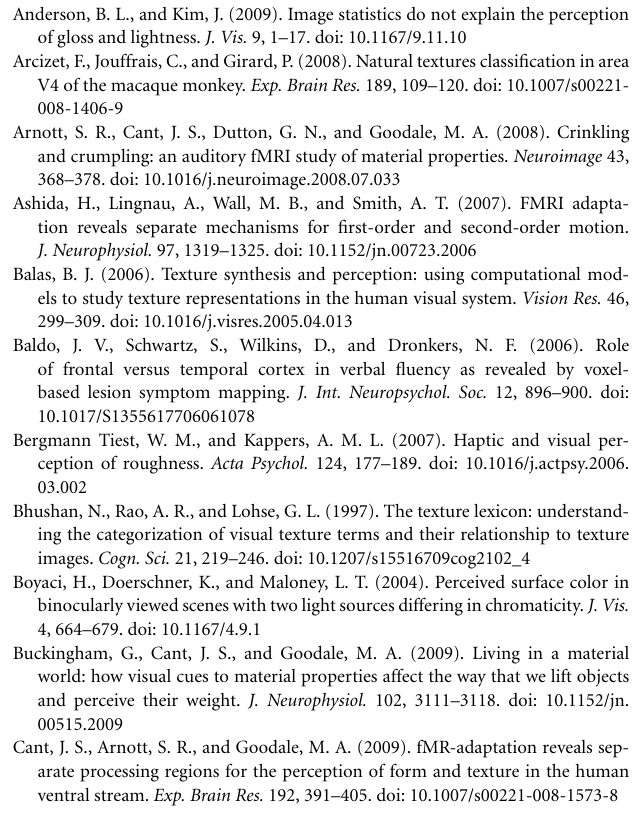
Figure S1 | Timecourses of the contrast between the no-adaptation conditions and the material adaptation conditions, in inferior parietal cortex. Figure S2 | Timecourses of the contrast between th2e no-adaptation conditions and the material adaptation conditions, in the right supramarginal gyrus. Figure S3 | Timecourses of the contrast between the no-adaptation conditions and the material adaptation conditions, in the right cerebellum. Figure S4 | Timecourses of the contrast between the no-adaptation conditions and the material adaptation conditions, in the left postcentral gyrus. Figure S5 | Timecourses of the contrast between the no-adaptation conditions and the material adaptation conditions, in the left precentral gyrus. Figure S6 | Timecourses of the contrast between the no-adaptation conditions and the material adaptation conditions, in the right precentral